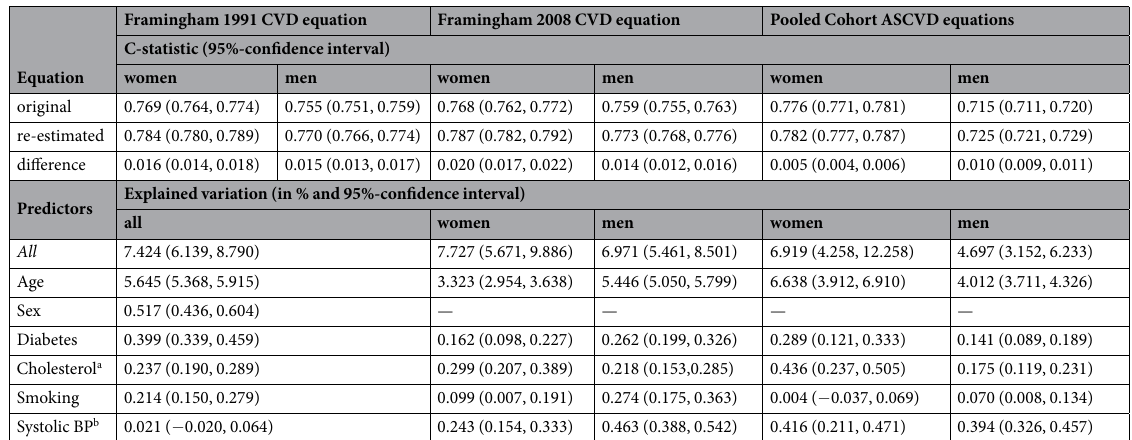
equation. Especially for individuals with higher predicted probabilities, re-estimation improved calibration for this equation. The original FR2008 equation overestimated the observed cumulative incidence of CVD especially for men. Updating improved its calibration as for the FR1991 equation. Applying the original PC equations led to considerable underestimation, also for individuals with low predicted probabilities. However, recalibration and